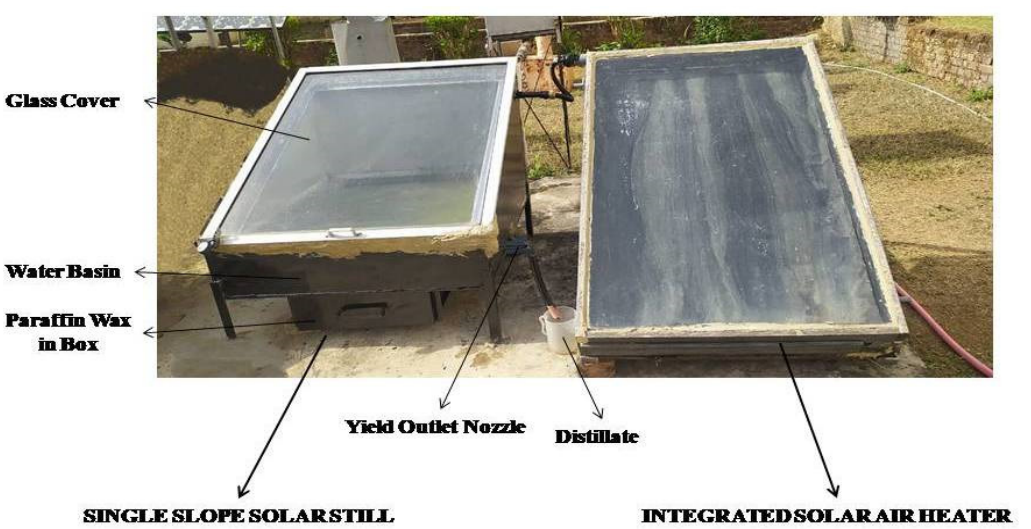
Figure 1. Schematic View of Latent Heat Storage Based Single-Slope Solar Still Assisted with Solar Air Heater.